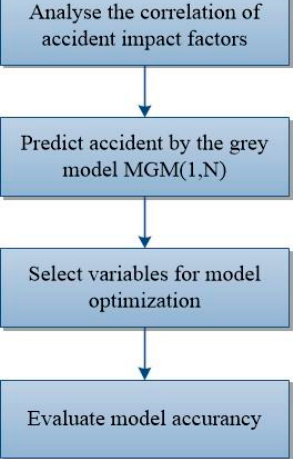
Figure 1. Framework of the predictive system for traffic accidents.